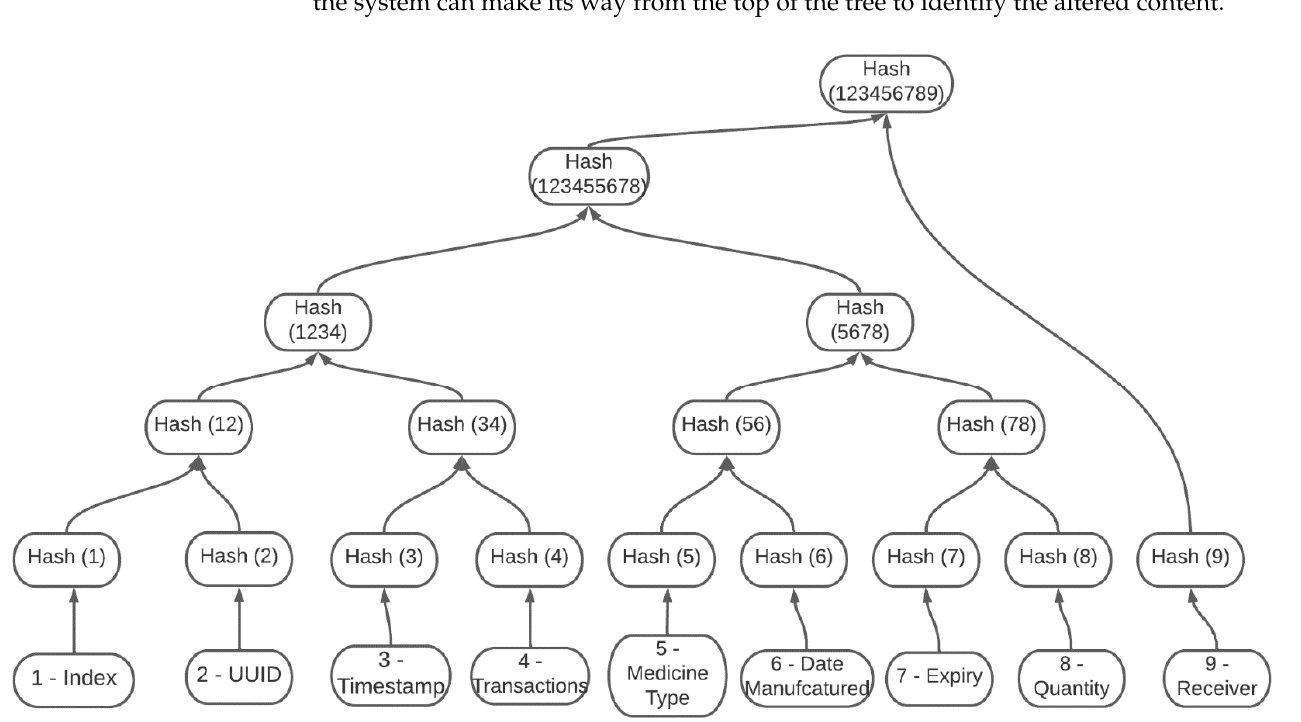
Figure 10. Merkle tree of block content.